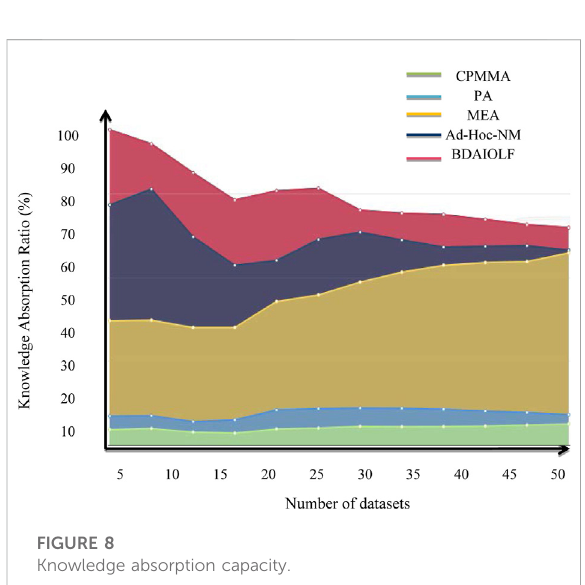
FIGURE 8 Knowledge absorption